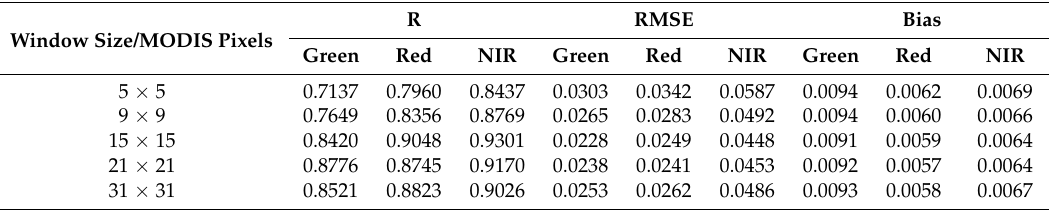
Table 3. Accuracy evaluation of downscaled MODIS data with different window sizes.